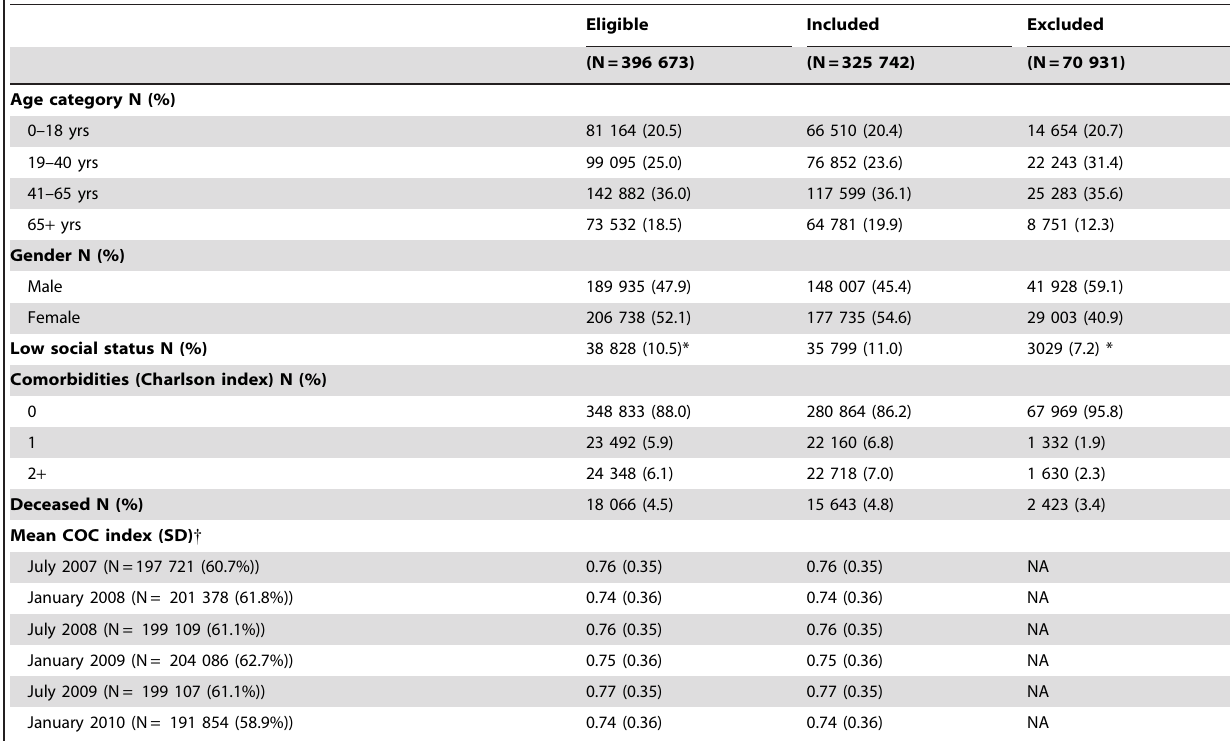
Table 1. Population characteristics.